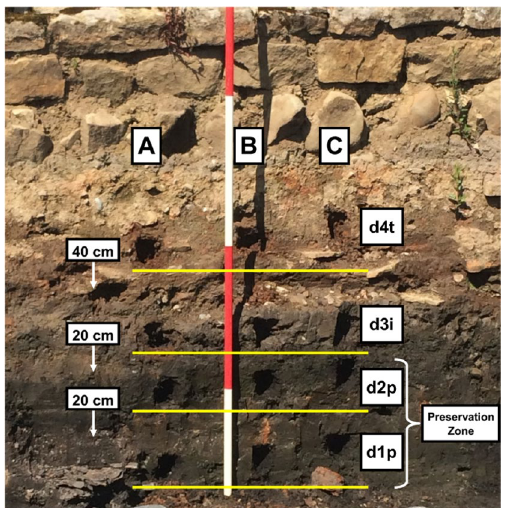
Figure 6. Archaeological section from the trench at Vindolanda where the samples were collected. ( A – C ) Replicate samples. d1–4: samples at depth (d) 1–4. Depths 1 and 2 representing the oldest archaeological contexts, associated with good preservation (p). Depth 3 is an interface (i)